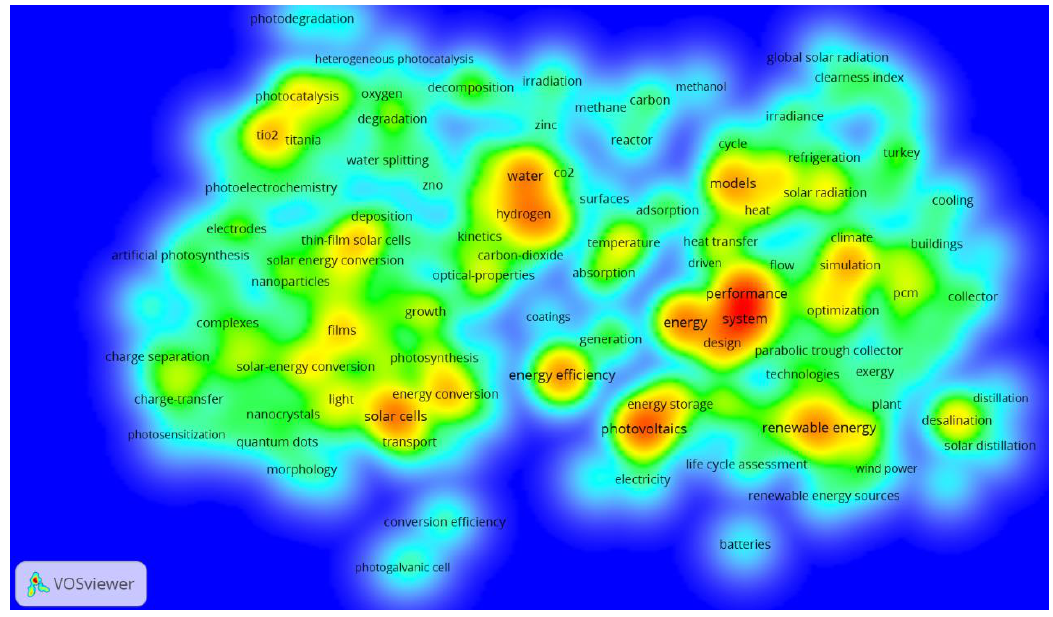
Figure 11. Hot topics in Solar Energy research in 2000–2010 (1% most common keywords). Figure 12 shows hot areas in solar energy early research during the 1990s. Due to the low number of publications, a reduced number of keywords were extracted (5,239), from which the map only represents the 1% most common ones that are meeting a minimum number of 15 appearances.